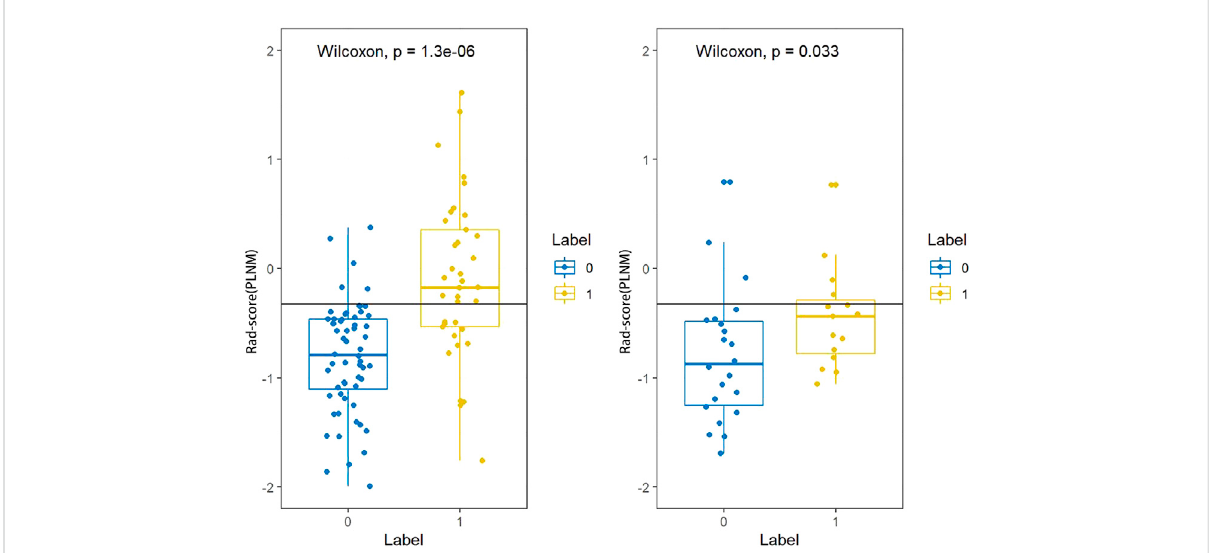
FIGURE 7 Rad-score (PLNM) distribution difference between PLNM negative subgroup and positive subgroup in the training dataset and testing dataset. The rad-score (PLNM) of patients with PLNM was higher than the rad-score (PLNM) of patients with non-PLNM in the training dataset and testing dataset ( p < 0.001, p < 0.05, respectively).